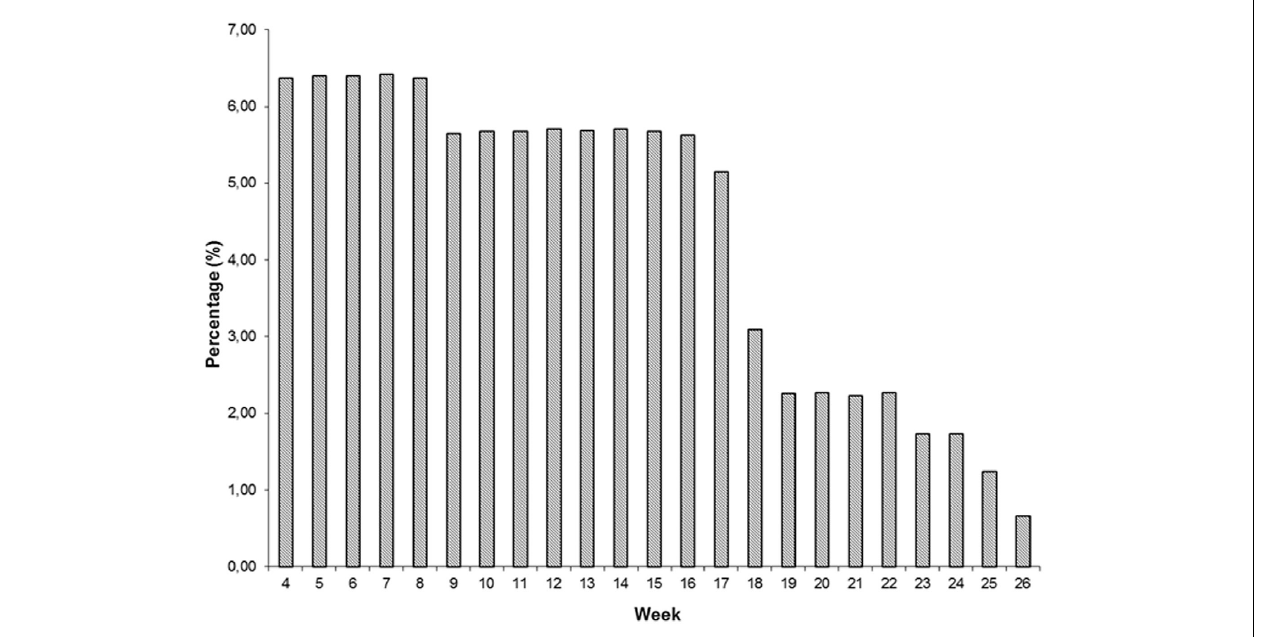
FIGURE 1 | Distribution of fecal egg count (FEC) samples ( n = 6375).